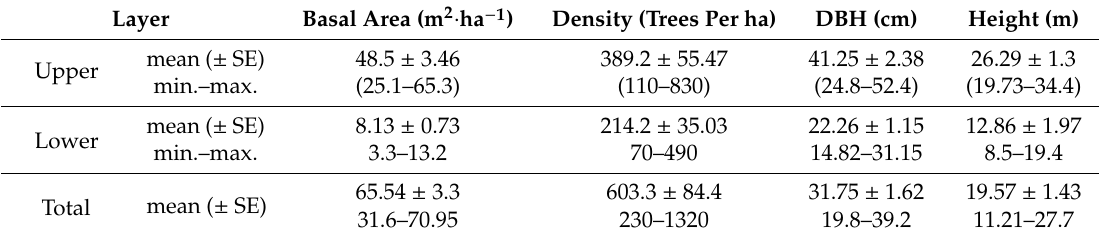
Table 2. Characteristics of the studied forest differentiated by canopy layers. A tree is considered in the upper layer when it reaches 80% of the average plot height.